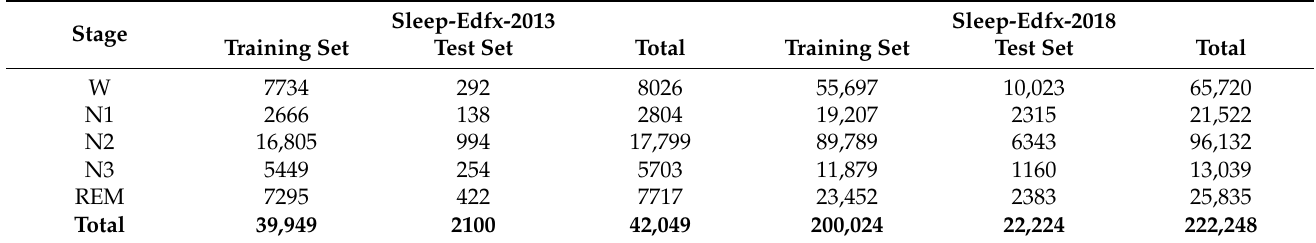
Table 2. Detailed distribution of sleep stages in sleep-edfx-2013 and sleep-edfx-2018